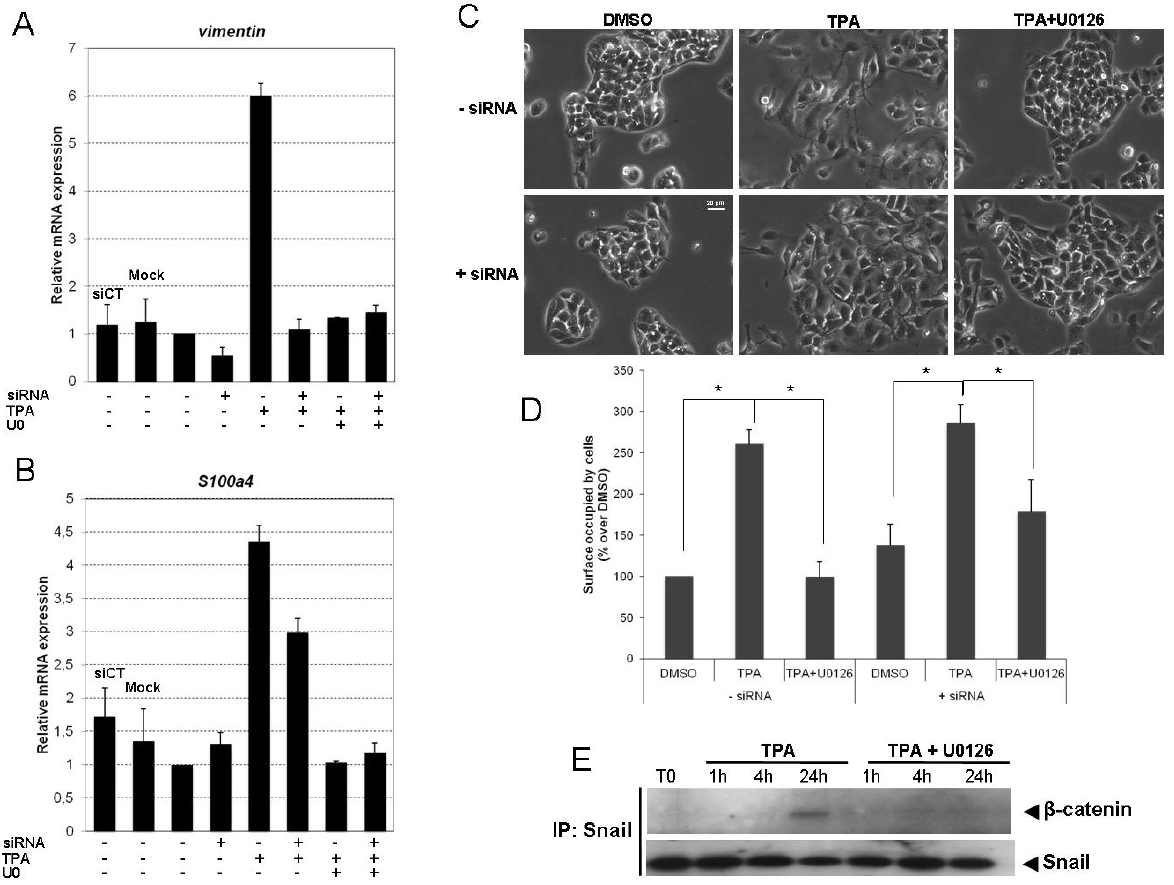
Figure 6. Snail knockdown restores the TPA-induced EMT only partially. ( A – C ) HepG2 cells were transfected by incubation with either 40 pmol Snail siRNAs or nonspecific siRNAs (CT) for 36 h. HepG2 siRNA transfectants were exposed to 100 nM TPA, with or without U0126. Vimentin ( A ) and S100a4 ( B ) mRNA levels were assessed by real-time RT-PCR after 48 h of TPA treatment, with or without U0126. Relative mRNA expression levels (normalized with respect to gapdh ) were determined and mRNA levels in DMSO-treated cells (untransfected condition) were set to 1. Error bars indicate the means ± SEM of triplicate determinations from three independent experiments; ( C ) 48 h after TPA treatment with or without U0126, cell morphology was examined under a light microscope; ( D ) Surfaces occupied by cells were quantified using Nikon software after acquisition of photography using the CCD camera coupled to inverted microscope. Results are expressed as percentage over DMSO (untransfected condition), designated as 100%. Error bars indicate the means ± SEM of triplicate determinations from two independent experiments. * p < 0.05; ( E ) The complex of Snail/β-catenin was examined by co-immunoprecipitation assays at 1, 4 or 24 h on HepG2 exposed to TPA with or without U0126. The co-immunoprecipitation results are representative of three independent repeats for each